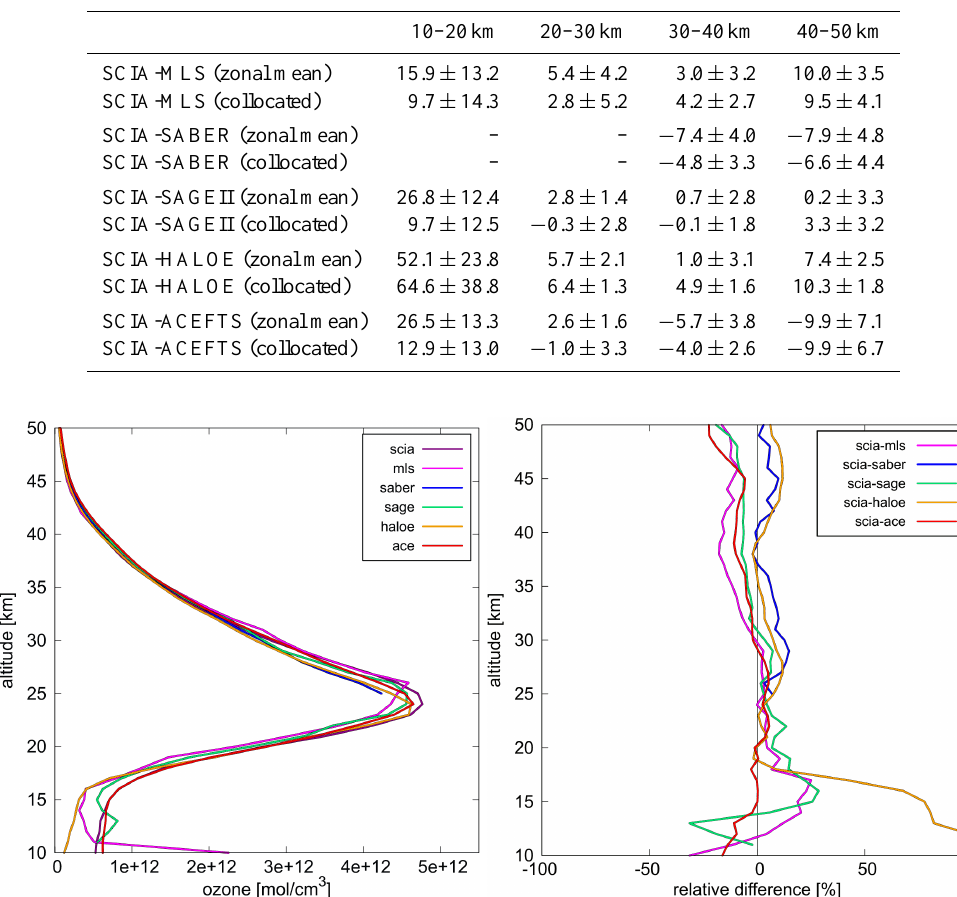
Fig. 1. Left: Monthly mean zonal mean ozone profiles from SCIAMACHY, MLS, SABER, SAGE II, HALOE, and ACE-FTS (August 2004, 20 ◦ S- 30 ◦ S). Right: Percent differences between SCIAMACHY and the other satellite instruments.